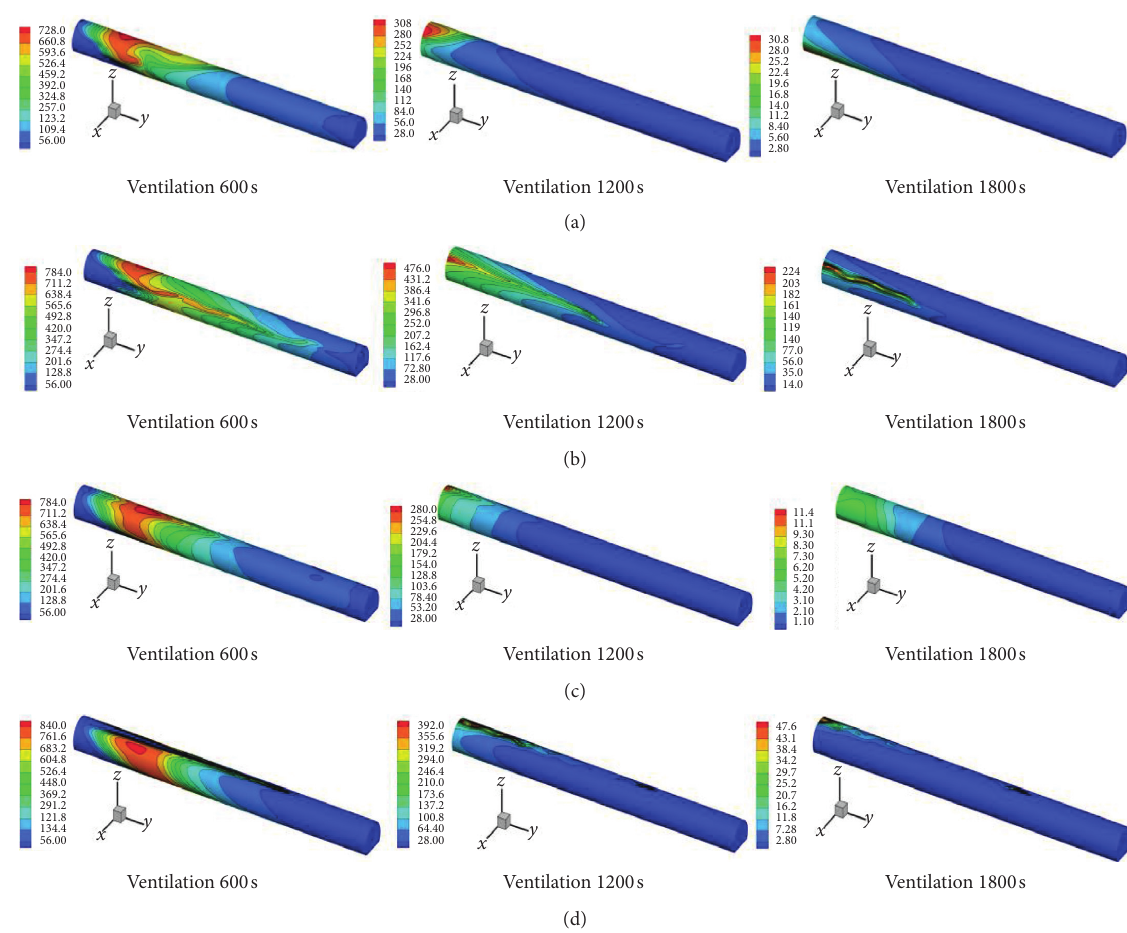
Figure 8: Influence of pipe setting on CO diffusion characteristics (mg/m 3 ). (a) Corner. (b) Haunch. (c) Center. (d)